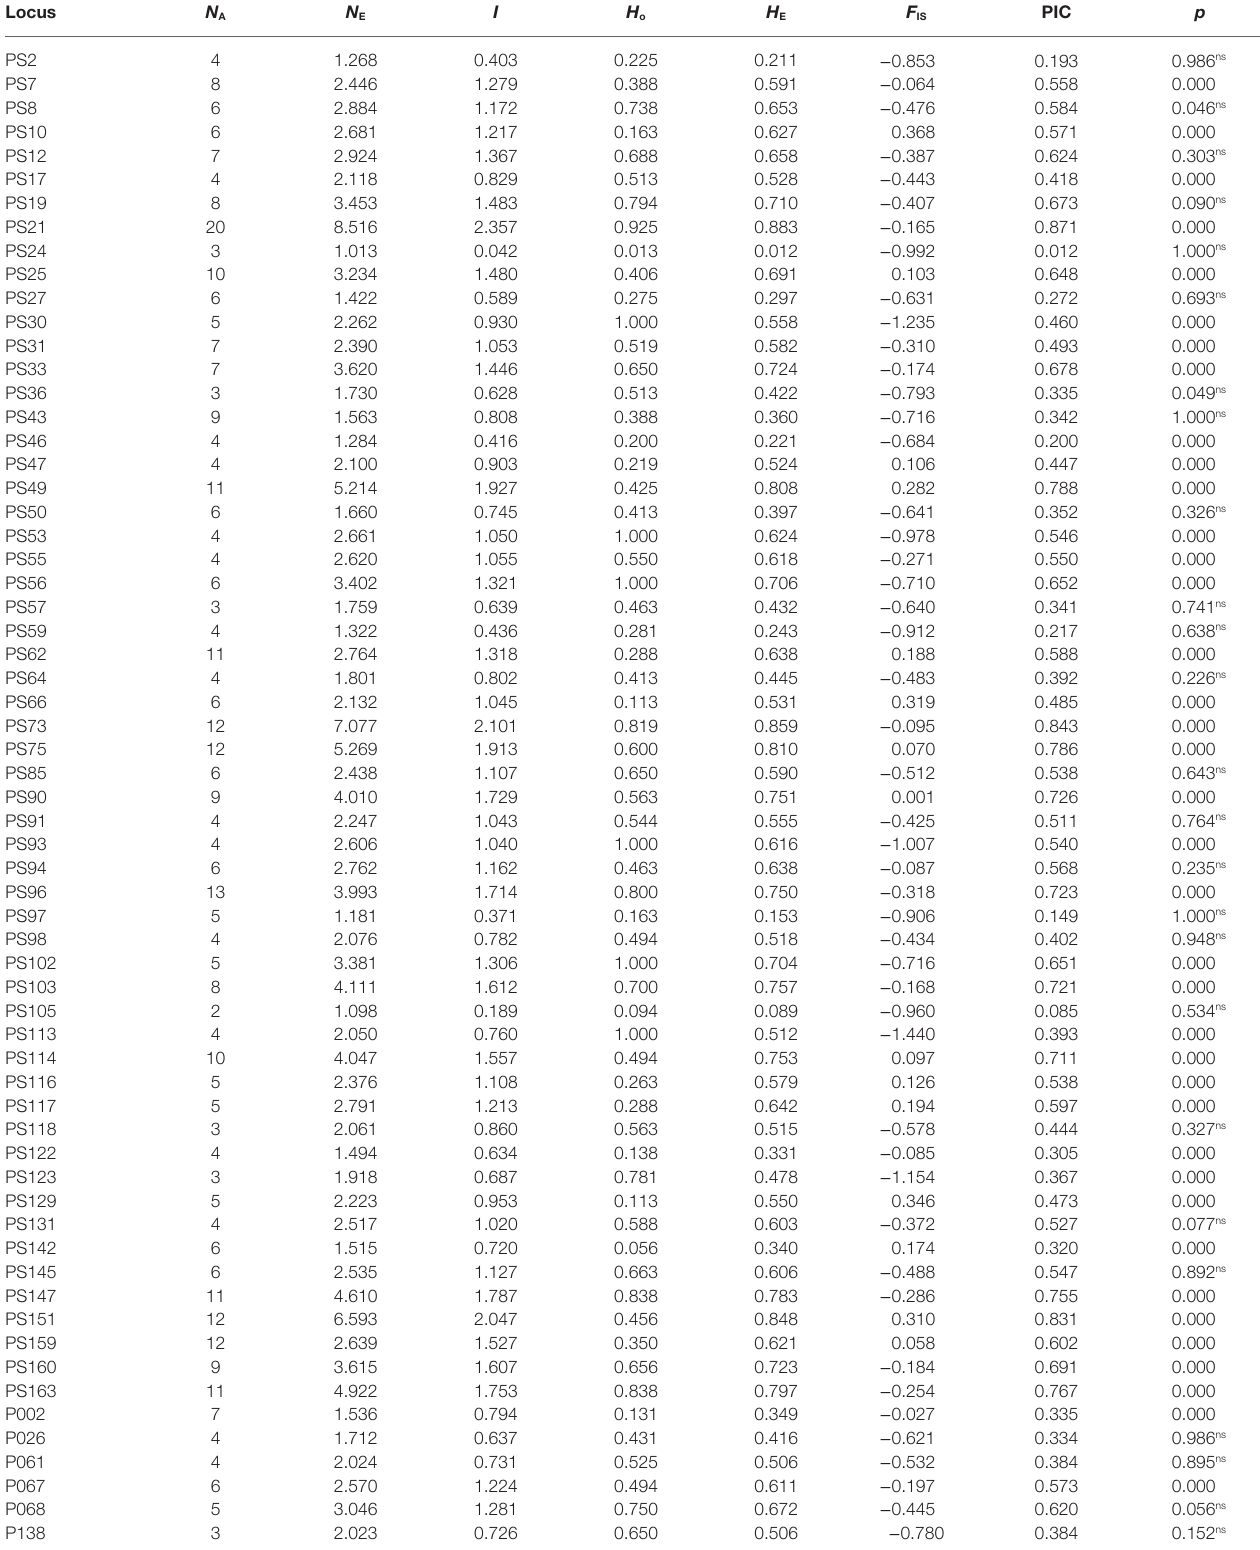
TABLE 3 | Diversity information parameter at 81 SSRs in 160 FTP